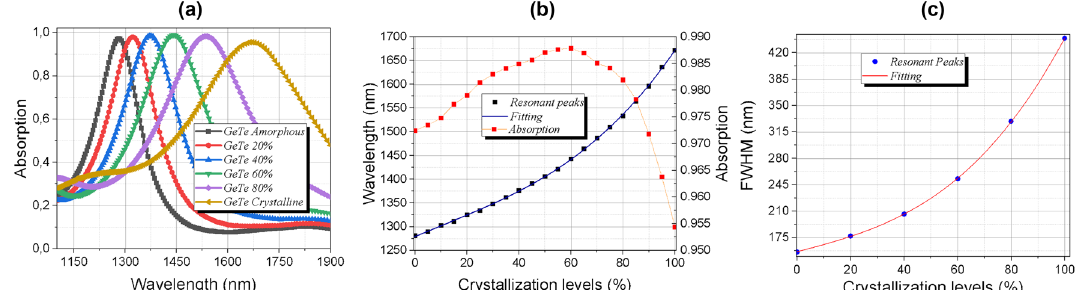
Figure 4. ( a ) The evolution of the absorption spectrum for different crystallization levels ( b ) by a fit polynomial of degree 3. The percentages shown in the legend correspond to the GeTe crystallization levels ( c ) Variation of the Full Width Half Maximum (FWHM) as a function of the crystallization of GeTe, by a fit also polynomial of degree